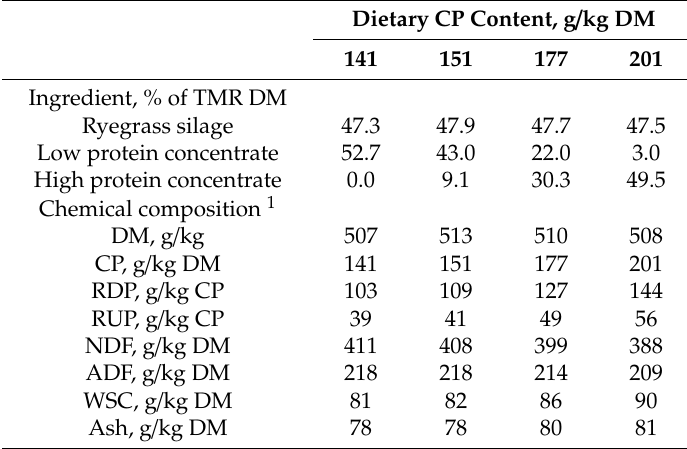
Table 2. Ingredients and chemical composition of the total mixed ration (TMR) diets.